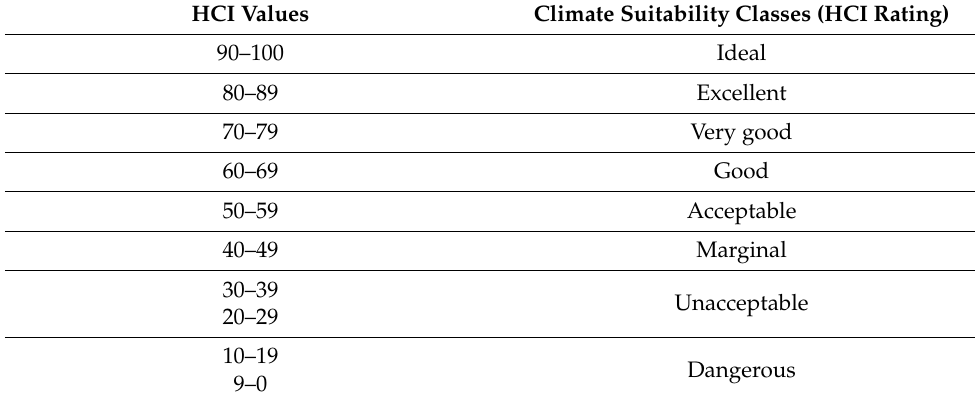
Table 1. HCI rating system (after Scott et al.,